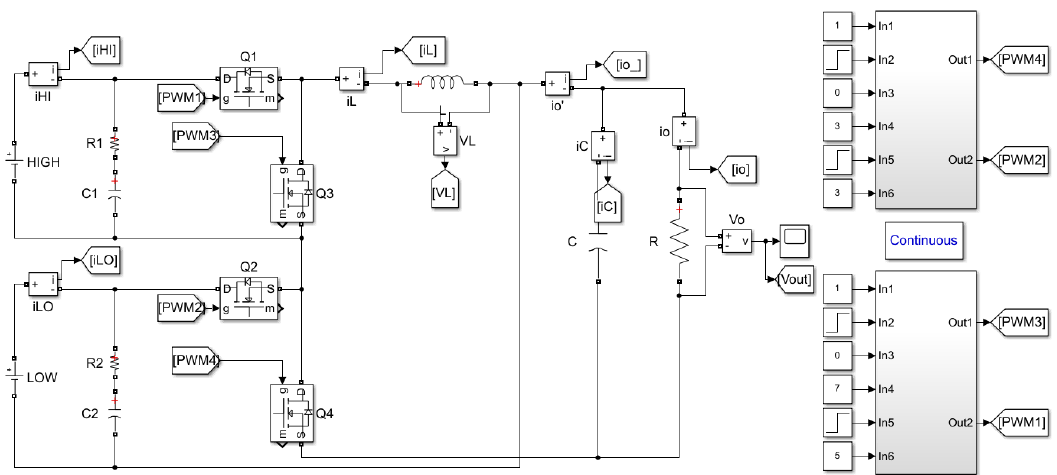
Figure 9. Circuit diagrams of the proposed bidirectional MIC in Matlab/Simulink.